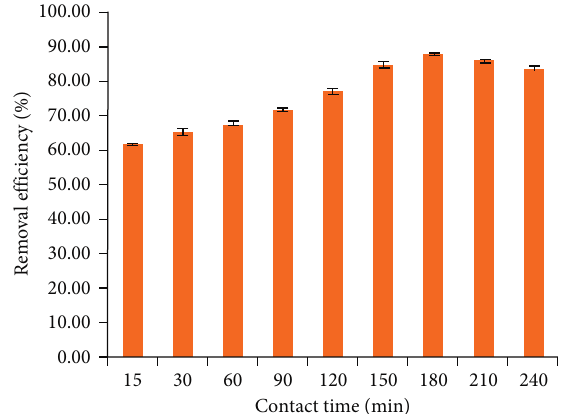
i Figure 5: Effect of ionic strength to the TC removal onto NCPML ( C i (TC) � 10mg/L), pH 4, contact time 180min, and adsorbent dosage of 5mg/mL. Error bars indicate the standard deviations of three replicates.